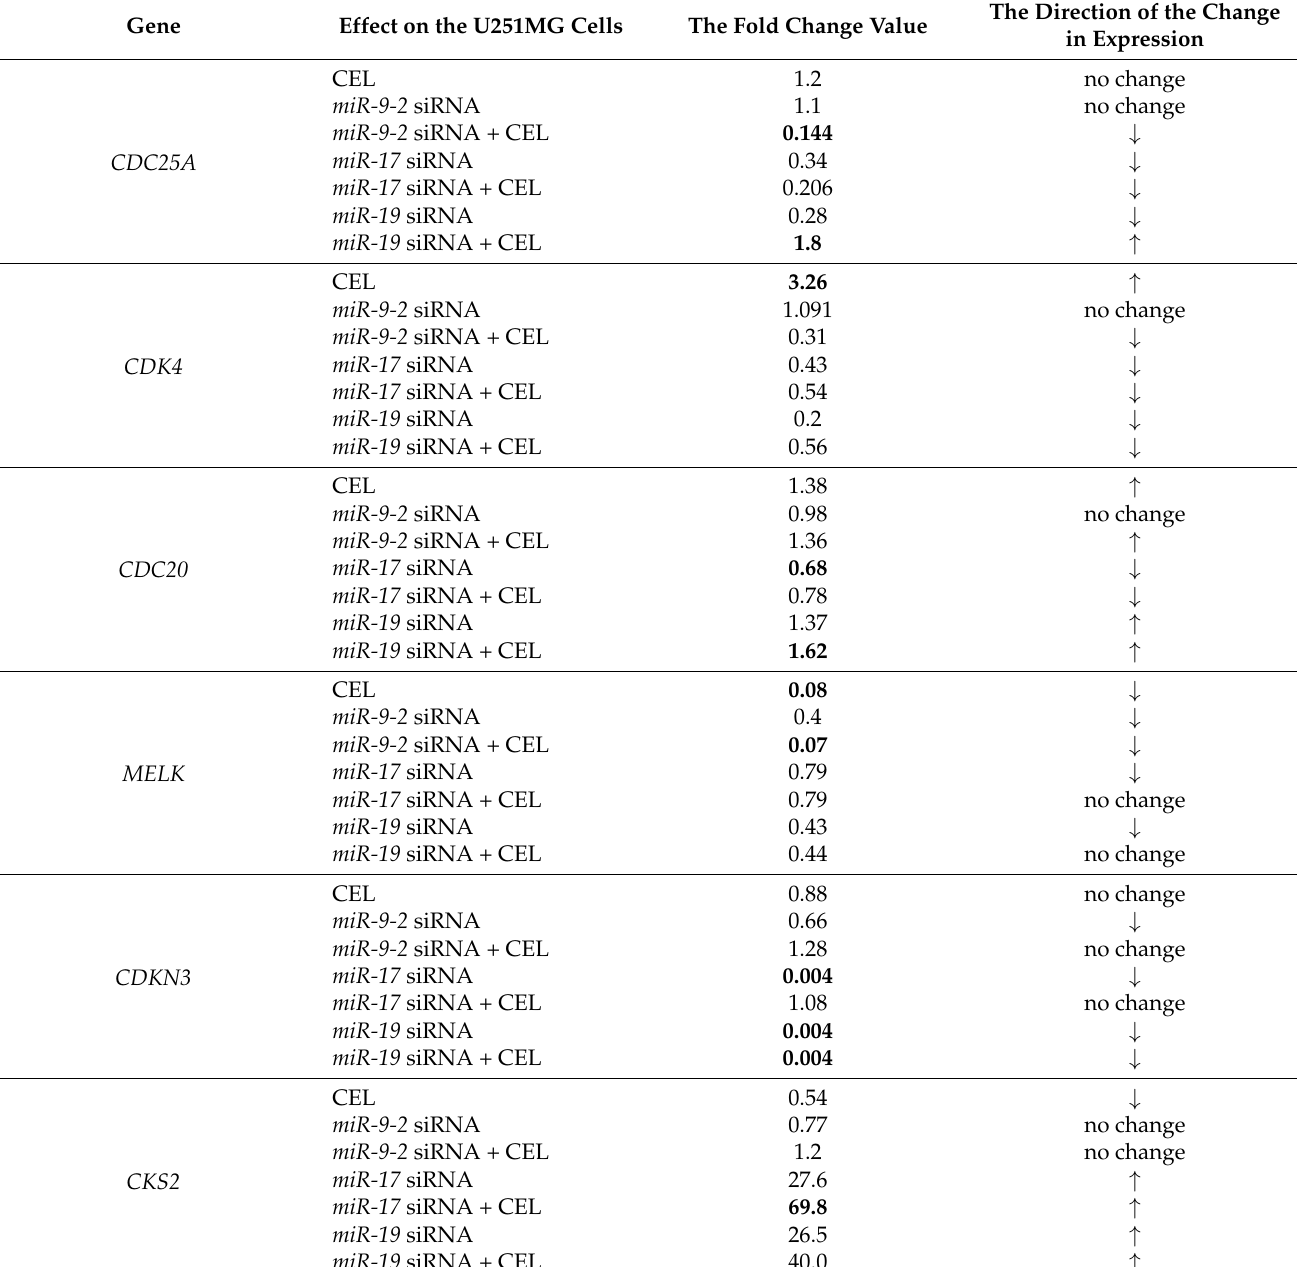
Table 3. Mean fold change value (relative to the control cells) and the direction of the change in the expression of the cell cycle-related genes in the U251MG